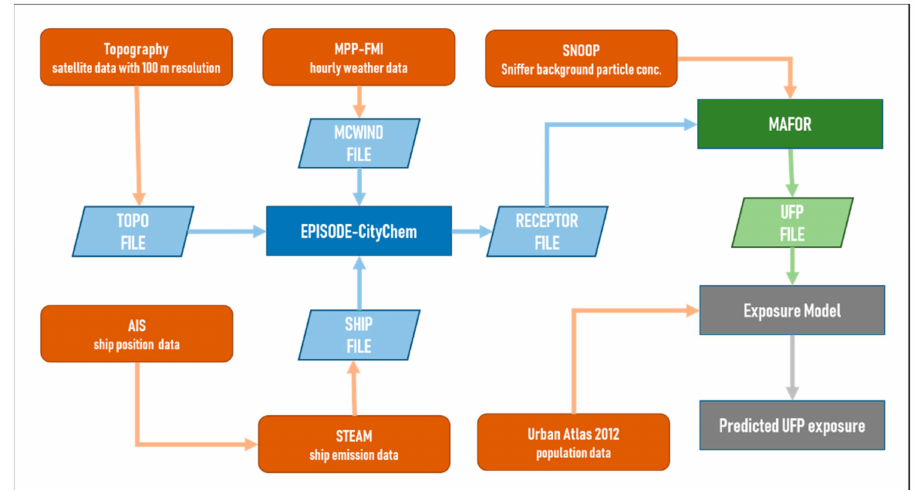
Figure 1. Outline of the sequential processing chain developed in this study. The brown and blue colors refer to the various input datasets and their initial processing, and the atmospheric dispersion and transformation modeling, respectively. The modeling of the aerosol processes and the exposure modeling together with the final product are presented with green and grey